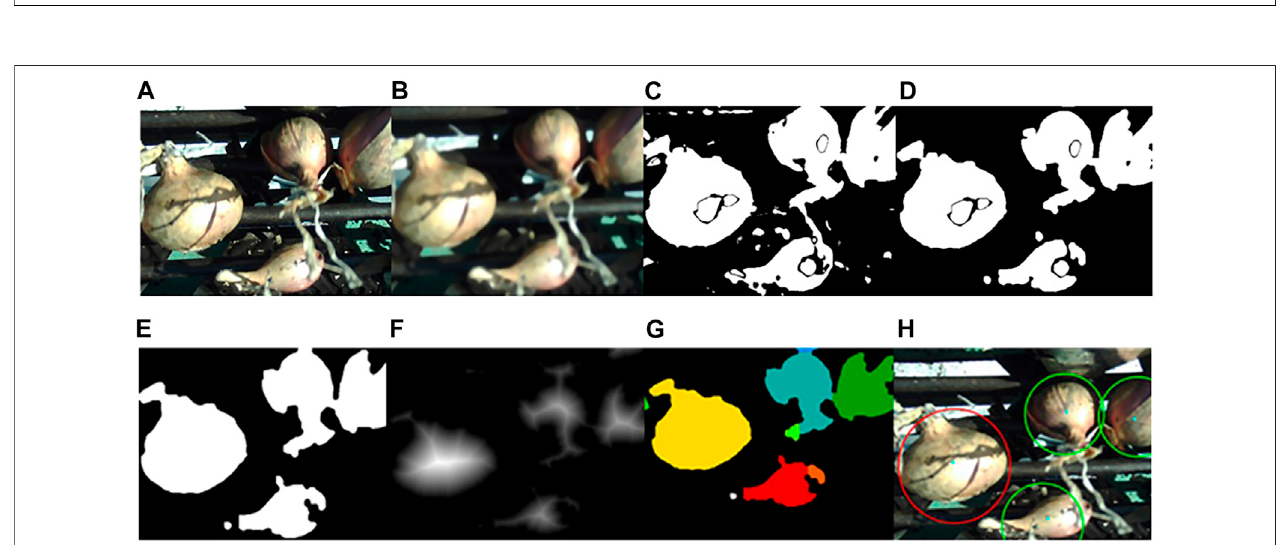
FIGURE3| Segmentationresults.Theoriginalimage (A) is fi rstpreprocessedbyblurringusinga9x9median fi lterand9x9Gaussian fi lter (B) .Itisthenconverted to the HSV color space and thresholded using a predetermined threshold value (C) . Morphological operations of opening (D) and closing are applied (E) , and the distance transform (F) is computed. Watershed segmentation is performed on the image to isolate individual onion regions (G) and identify and classify them in the original image (H) .